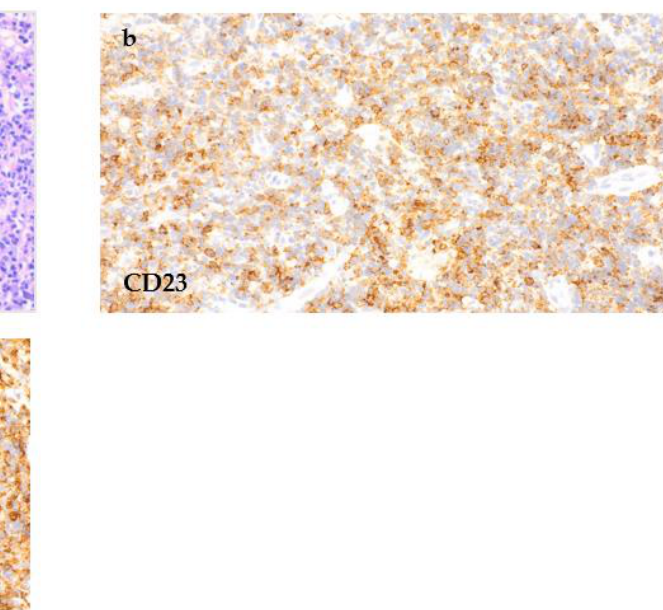
Figure 3. EBV-MCU of the hypopharynx. Tissue samples of the hypopharyngeal ulcer taken directly below the epithelial ulceration by incisional biopsy, showing a polymorphous cell infiltrate with HRS-like cells in an inflammatory background (( a ), Giemsa stain, 400×) that show positivity in the EBER in situ-hybridization (( b ), EBER, 100×) and for CD20 (( c ), 400×) and CD30 (( d ), 400×).